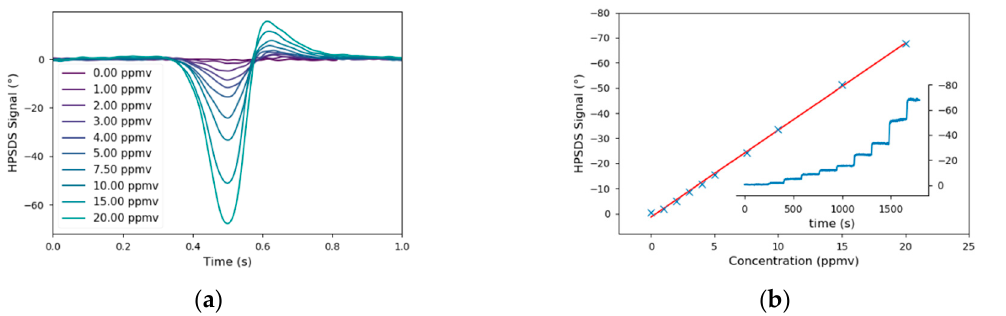
Figure 8. Heterodyne Phase Sensitive Dispersion Spectroscopy (HPSDS) spectra ( a ) from the calibration of CO ( b ). The asymmetry of the spectra is the result of the rather high laser current, which is necessary to achieve a sufficient signal on the detector.